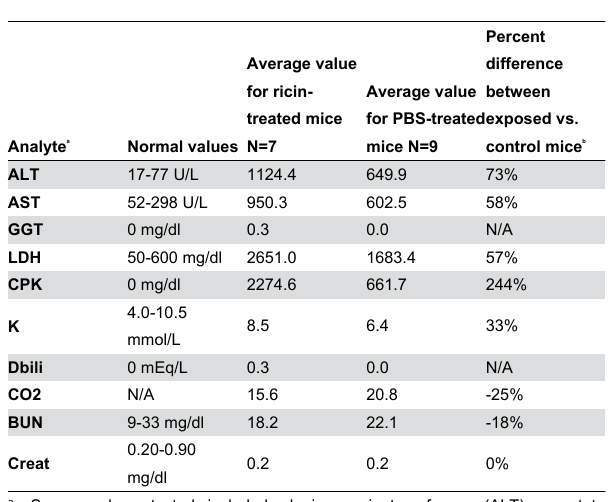
Table 4. Blood Chemistry Profiles From Intoxicated Mice That Were Collected Approximately 30 Hours After Ricin Exposure Compared With Un-Intoxicated Control